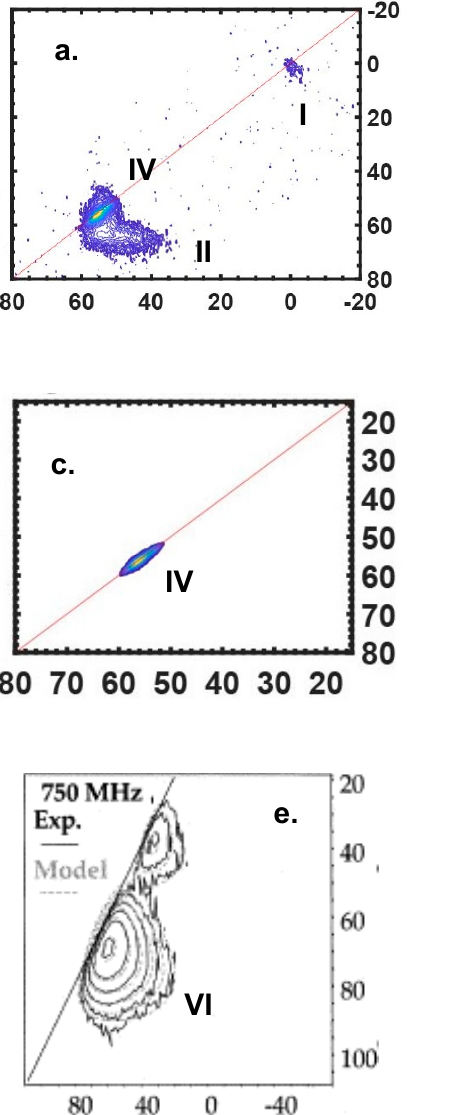
Figure 7. Experimental spectra showing sheared MQMAS spectra of the six scenario lineshapes described in Table 1, with the indication of chemical shift (CS) and / or quadrupole induced shift (QIS) lines. Projections are not shown as the focus is on the lineshape analysis. The detailed information of all figures are: ( a ) 27 Al MQMAS for hydrated zeolite HZSM-5 at 14.1 T; ( b ) 27 Al MQMAS of zeolite HUSY; ( c ) 27 Al MQMAS for the same hydrated zeolite HZSM-5 in ( a ) but at 35.2 T; ( d ) 17 O MQMAS for hydrated zeolite HZSM-5 at 18.8 T and ( e ) 27 Al MQMAS of CaO-Al 2 O 3 -SiO 2 glass at 17.6 T. ( a ) and ( c ) are reprinted (adapted) with permission from Ref. [8]. Copyright (2020) American Chemical Society. ( b ) is reprinted from Ref. [59], Copyright (2010), with permission from Elsevier. ( d ) was acquired at 18.8 T at National High Magnetic Field Laboratory. ( e ) is reprinted from Ref. [2], Copyright (2004), with permission from Elsevier.